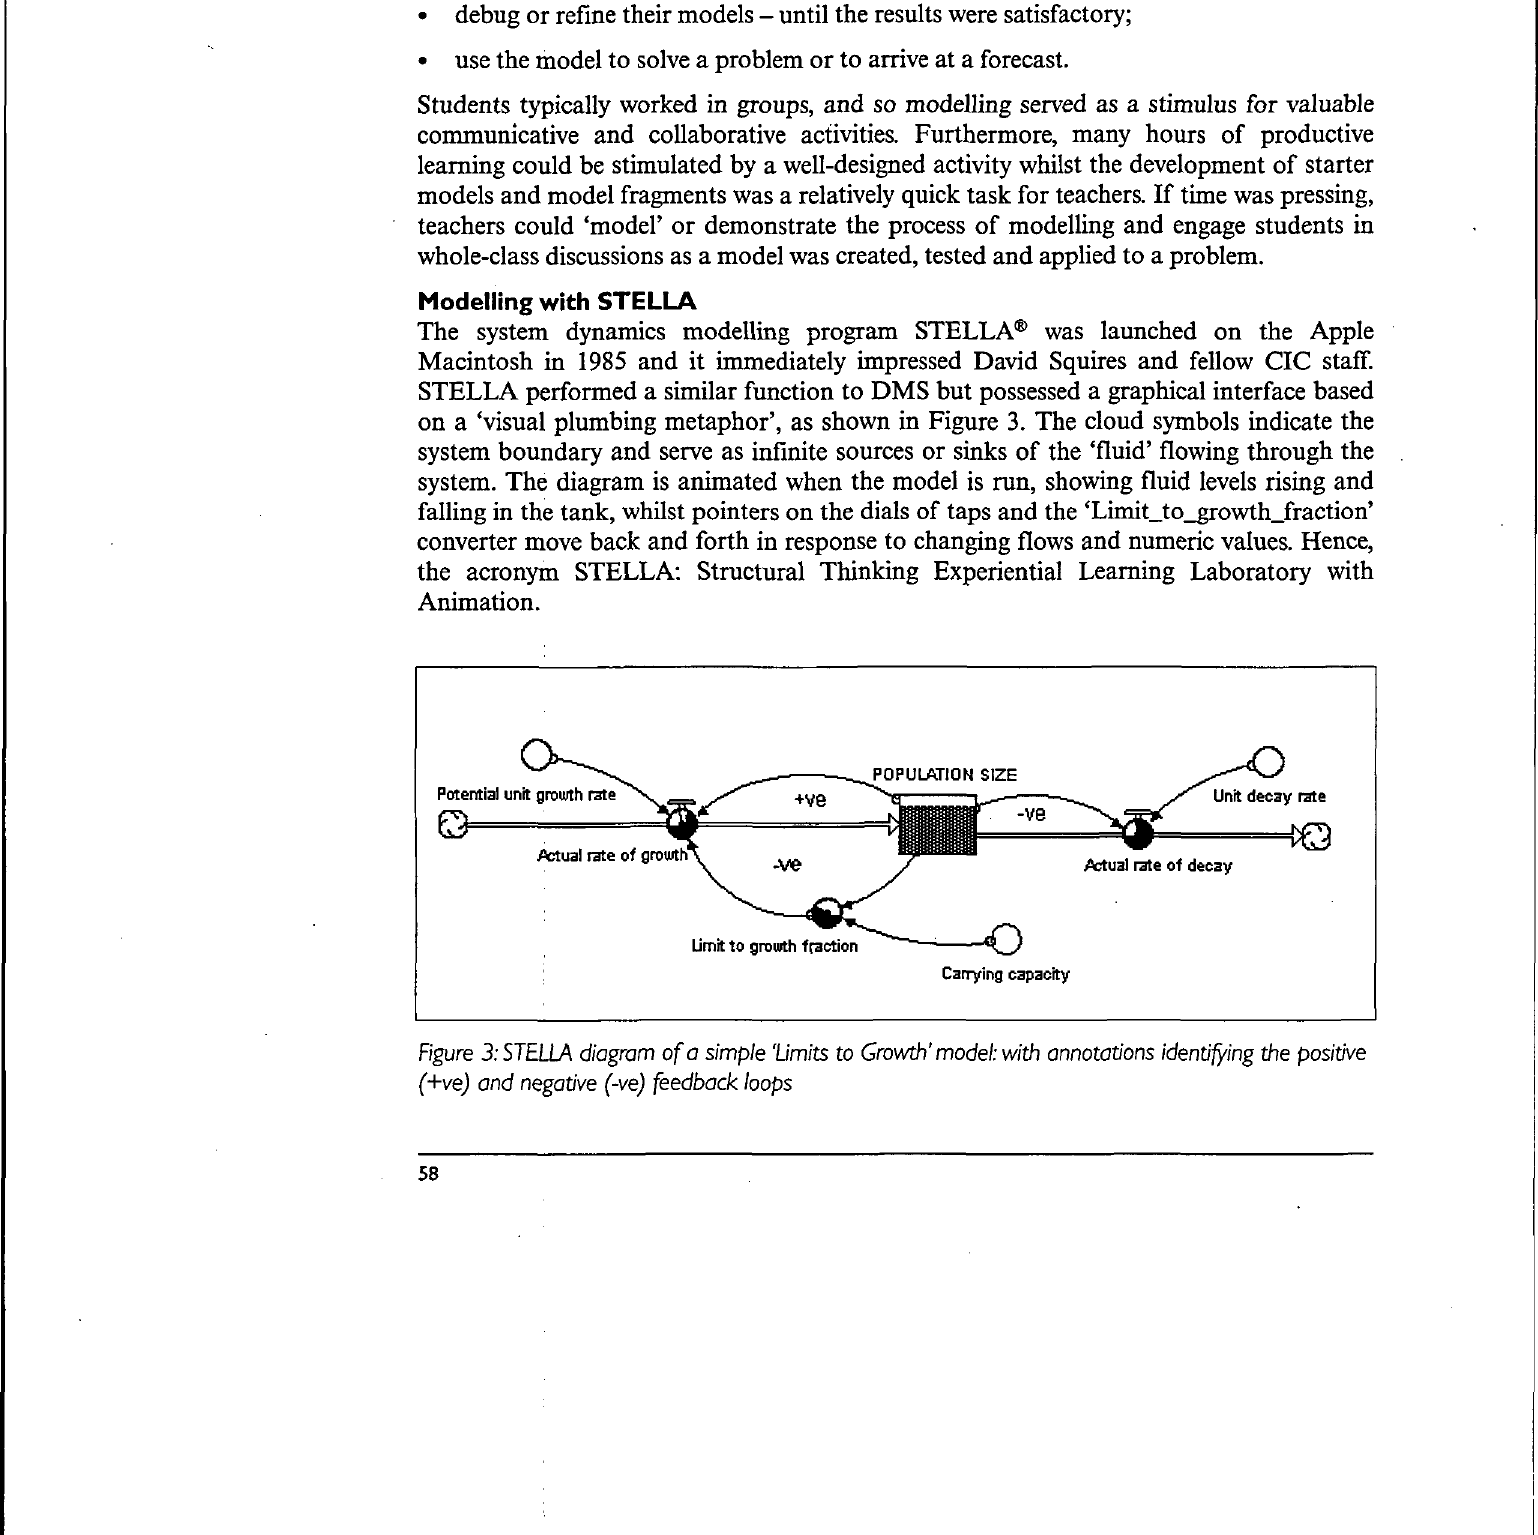
figure 3: STELLA diagram of a simple 'Limits to Growth'model: with annotations identifying the positive (+ve) and negative (-ve) feedback